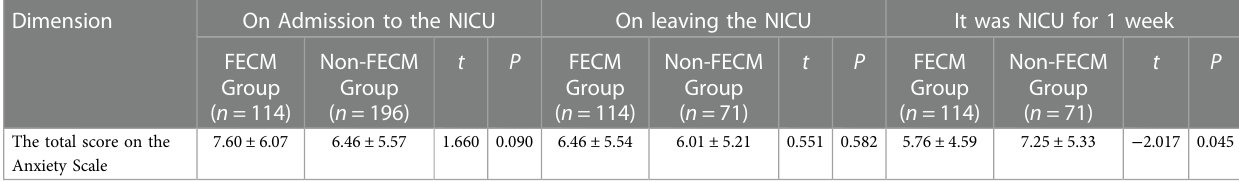
TABLE 2 The scores of the self-rating anxiety scale (GAD-7) of the main caregivers of premature infants in the two groups at discharge and 1 week after discharge. Dimension